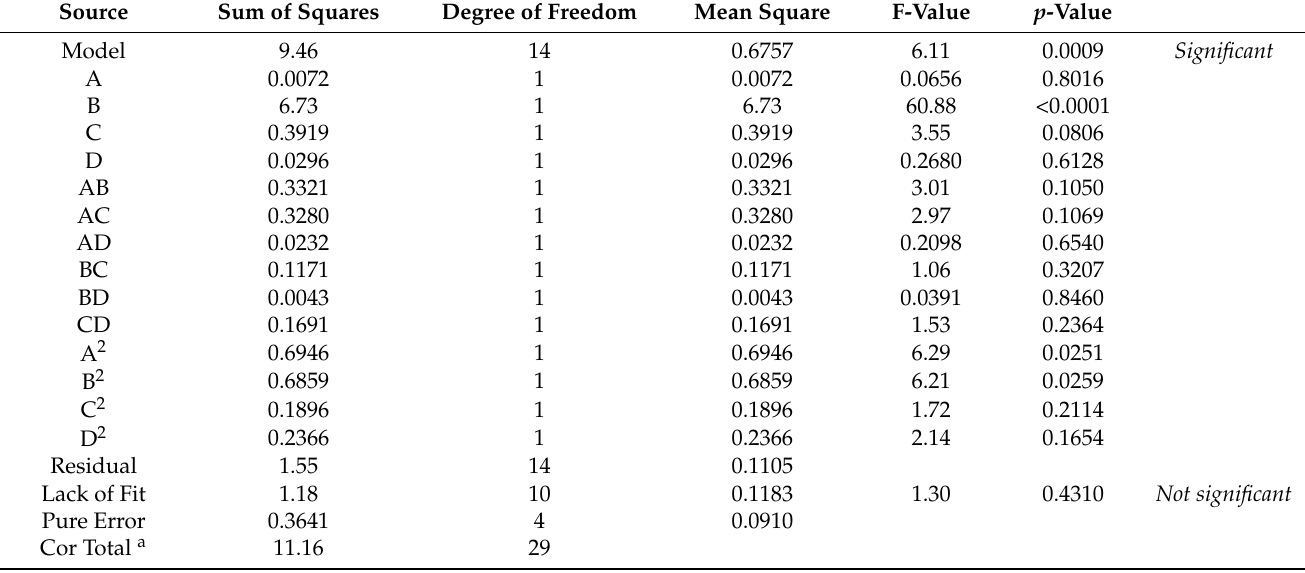
Table 3. The ANOVA results of CCD for graphene–indium oxide